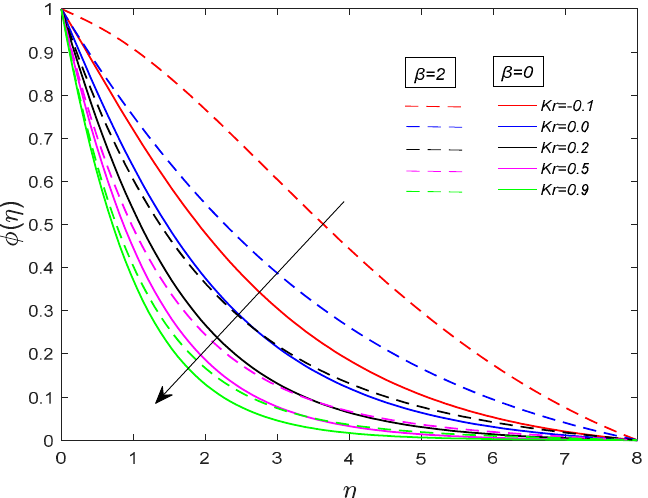
Figure 16. Effect of chemical reaction parameter (Kr) on concentration profile with Pr = Sc = 0.7, M = 0.5, Ec = Sr = 0.1.